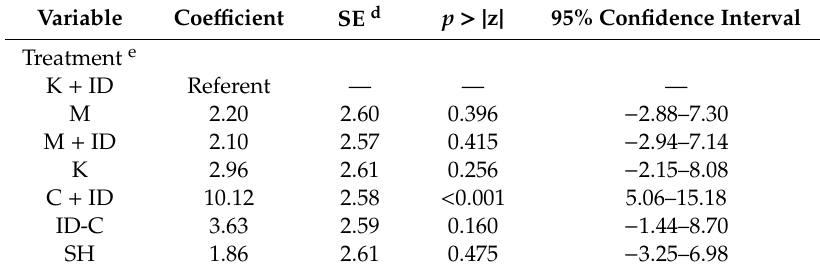
Table 3. Overall navigation time (seconds) by treatment group using ketoprofen and iron dextran (K + ID) treatment group as the referent category, accounting for additional fixed a and random b e ff ects (model 1) c